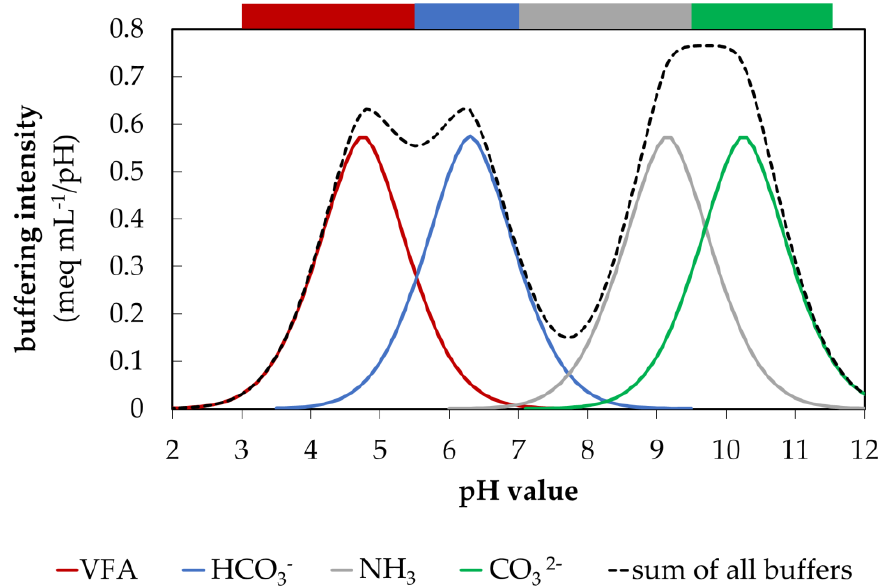
Figure 1. Dynamics in buffering intensity with pH for different buffers commonly found in anaerobic digesters; vertical bars indicate the boundaries between the buffer areas (modified according to [22]).